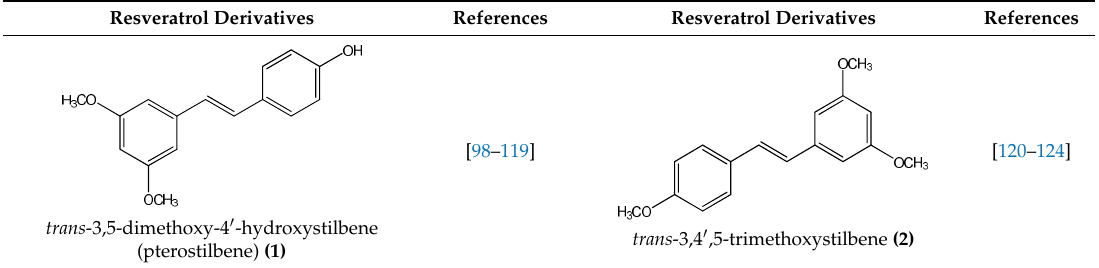
Table 3. Chemical structures of resveratrol derivatives tested in in vitro and/or in vivo models.